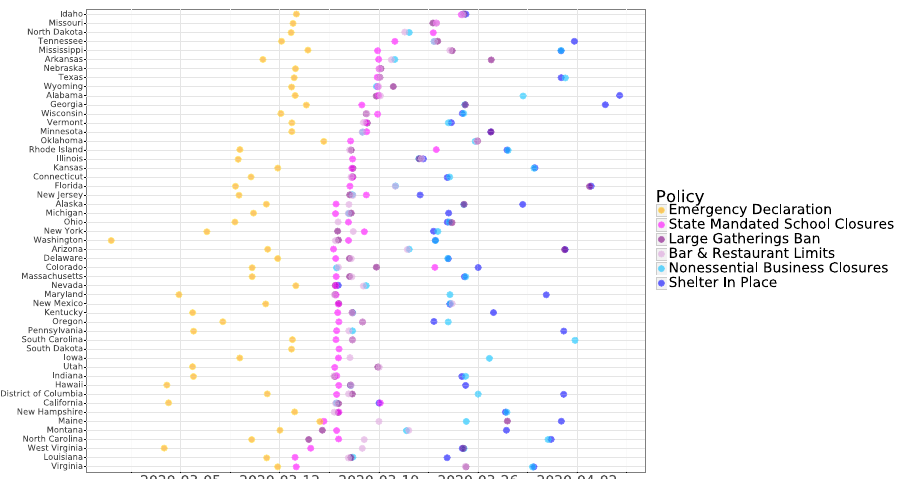
Fig. 1 Implementation of state-level policies in response to COVID-19, ordered by date of fi rst social distancing policy. Although policies implemented through April 5, 2020 are shown, only effects of policies implemented through March 23, 2020 were